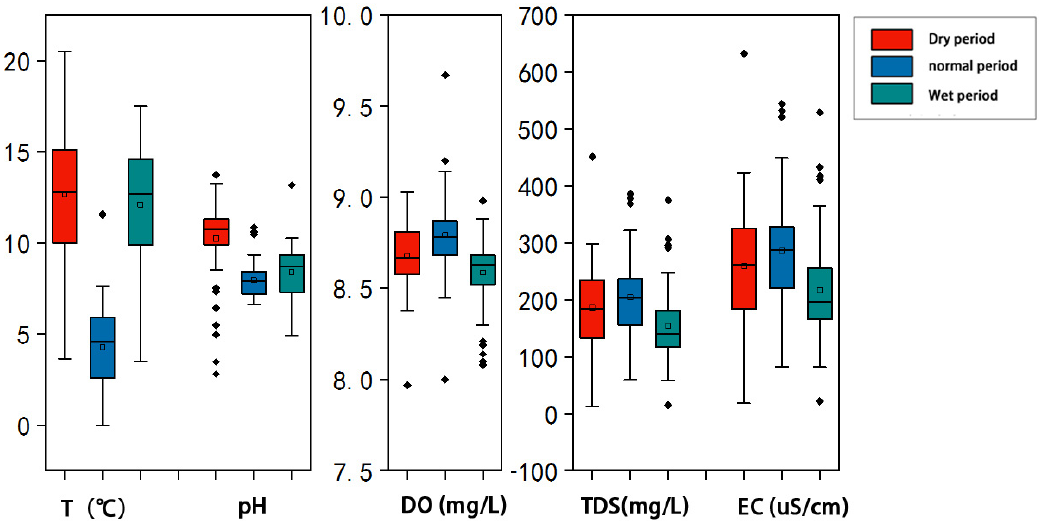
Figure 2. Boxplots of basic physical and chemical properties (pH, T (Water temperature) ( ◦ C), Do (Dissolved oxygen) (mg/L), EC (Electrical conductance)( µ S/cm), TDS (Total dissolved solids) (mg/L)) of the Yarlung Tsangpo River during wet, normal and dry seasons. Table 1. Summary statistics of hydrochemical composition of the Yarlung Tsangpo and its compar- ison with other rivers around the world.